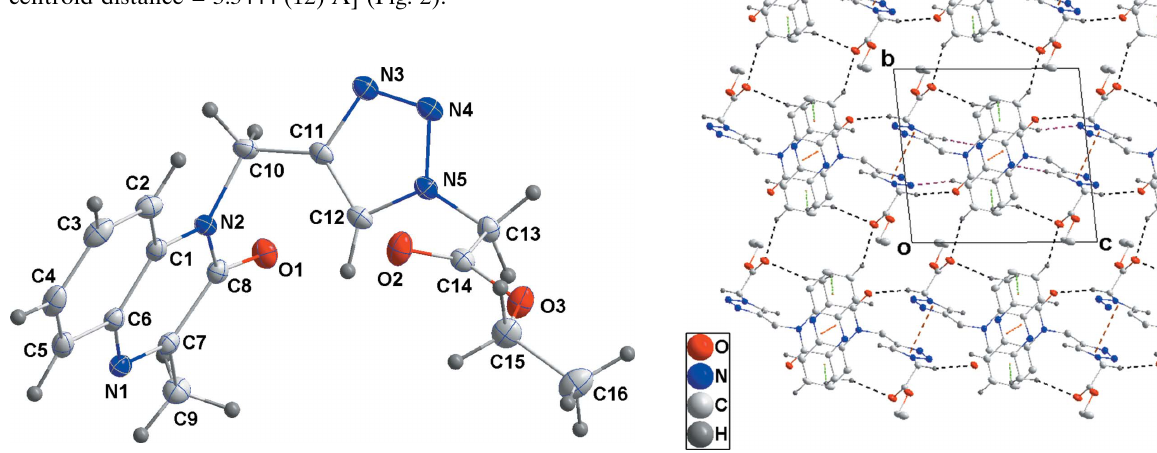
Figure 3 Plane view of one layer along the a -axis direction with intermolecular interactions depicted as in Fig.